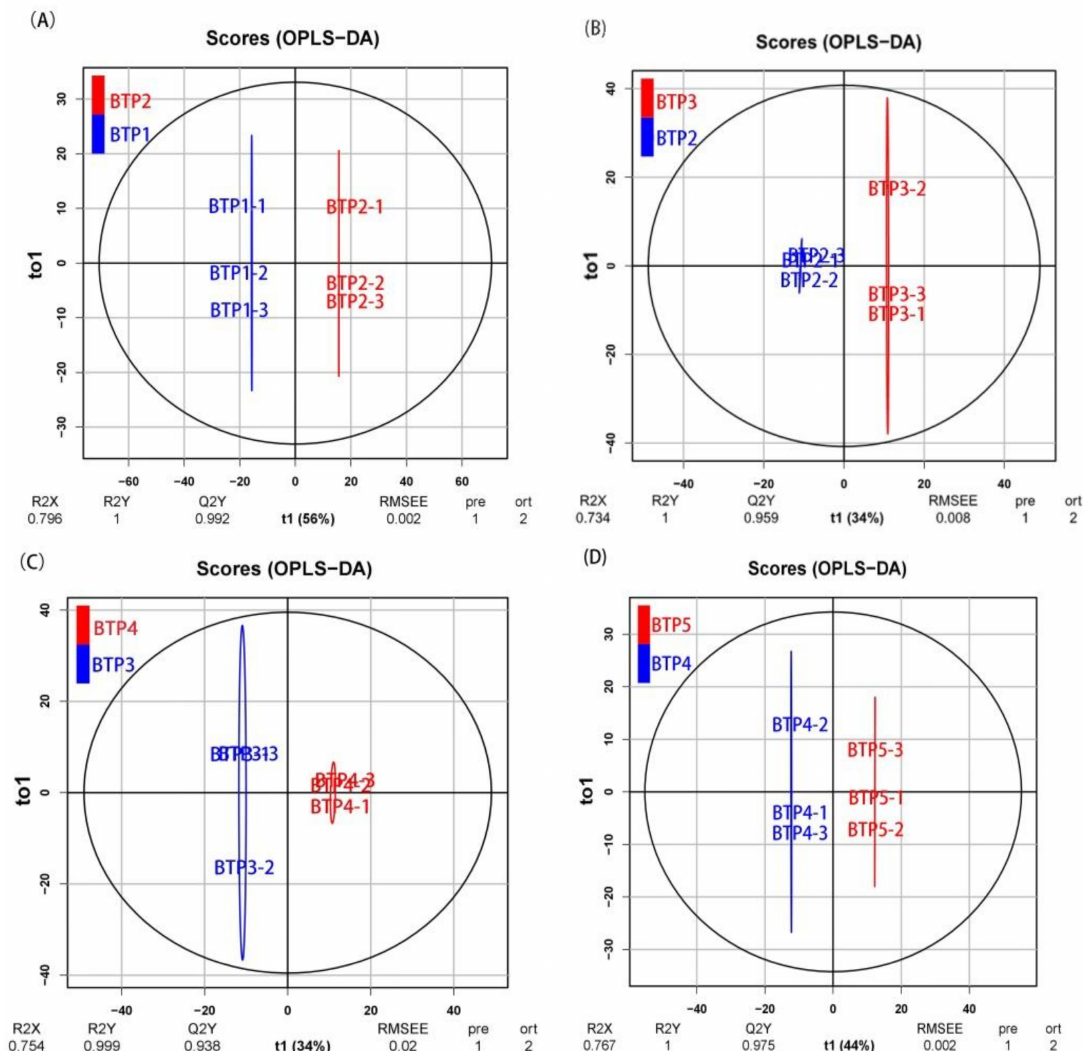
Figure 2. OPLS-DA score plots demonstrating the clustering pattern of metabolites in subsequent development stages of tea flowers. X-axes represent PC1, Y-axes represent PC2; RMSEE represent Root Mean Square Error of Estimation. ( A ) BTP1 vs BPT2 group (R2Y = 1, Q2Y = 0.992, RMSEE = 0.002); ( B ) BTP2 vs BPT3 group (R2Y = 1, Q2Y=0.959, RMSEE = 0.008); ( C ) BTP3 vs BPT4 group (R2Y = 0.999, Q2Y = 0.938,RMSEE =0.02); ( D ) BTP4 vs BPT5 group (R2Y = 1, Q2Y = 0.975,RMSEE = 0.002). Altogether, twelve anthocyanins were identified from BTP flowers, including procyanidin B2, procyanidin B3, pelargonidin 3- O -beta- D -glucoside, pelargonin, cyanidin, cyanidin 3,5- O - diglucoside, cyanidin O -syringic acid, luteolin O -hexosyl- O -hexosyl- O -hexoside, cyanidin 3- O -rutinoside, peonidin, petunidin 3- O -glucoside, and malvidin 3,5-diglucoside (Supplementary Table 1). Excluding procyanidins, the predominant anthocyanins were found to be cyanidin and its glycoside-derived compounds, namely cyanidin 3,5- O -diglucoside, cyanidin 3- O -glucoside, and cyanidin O -syringic acid. Among the anthocyanin compounds discovered in BTP flowers, 3 had never before been discovered in Camellia sinensis L. These novel anthocyanin compounds include pelargonidin 3- O -beta- D -glucoside, petunidin 3- O -glucoside, and cyanidin O -syringic acid. Two of the three novel anthocyanin compounds were also among the compounds found in particularly high concentration in BTP flowers, suggesting that these two compounds (cyanidin O -syringic acid and petunidin 3- O -glucoside) may be instrumental in explaining the unique phenotype of BTP